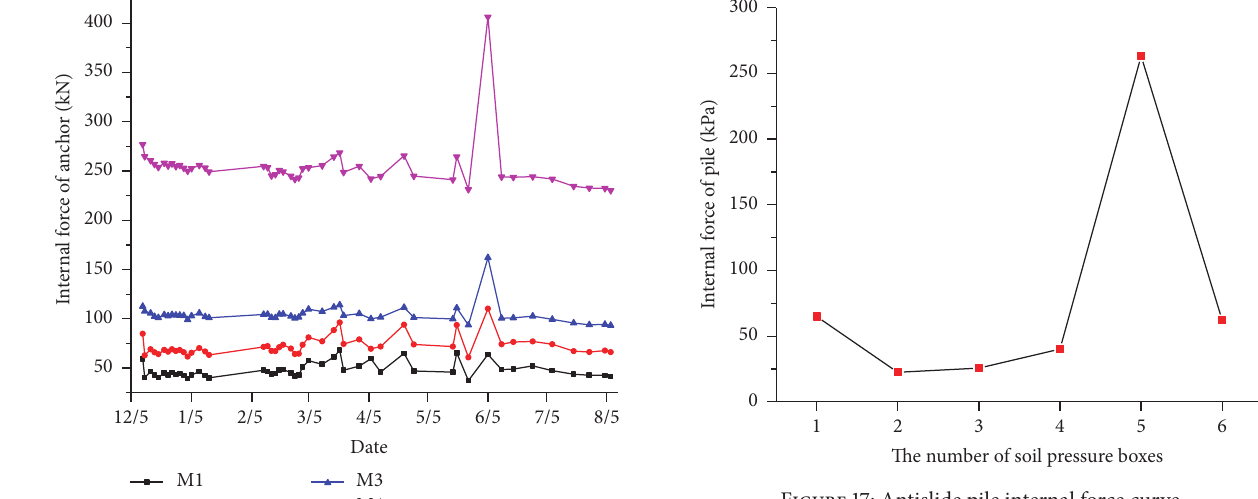
Figure 17: Antislide pile internal force